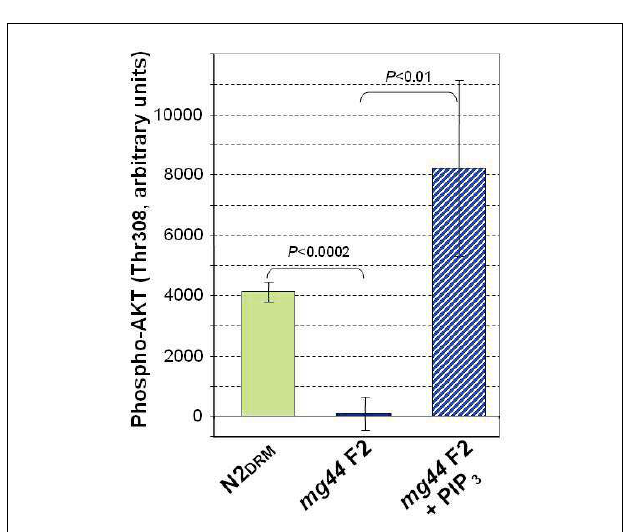
FIGURE 3 | In vivo 32 P-labeling of PIP 2 and PIP 3 . Young adult worms were washed and incubated 16h in phosphate-free medium to which 0.6mCi 32 PO 4 were added.Where indicated, worms were exposed 45min to 16-mM H 2 O 2 ; lipids were extracted, chromatographed, and